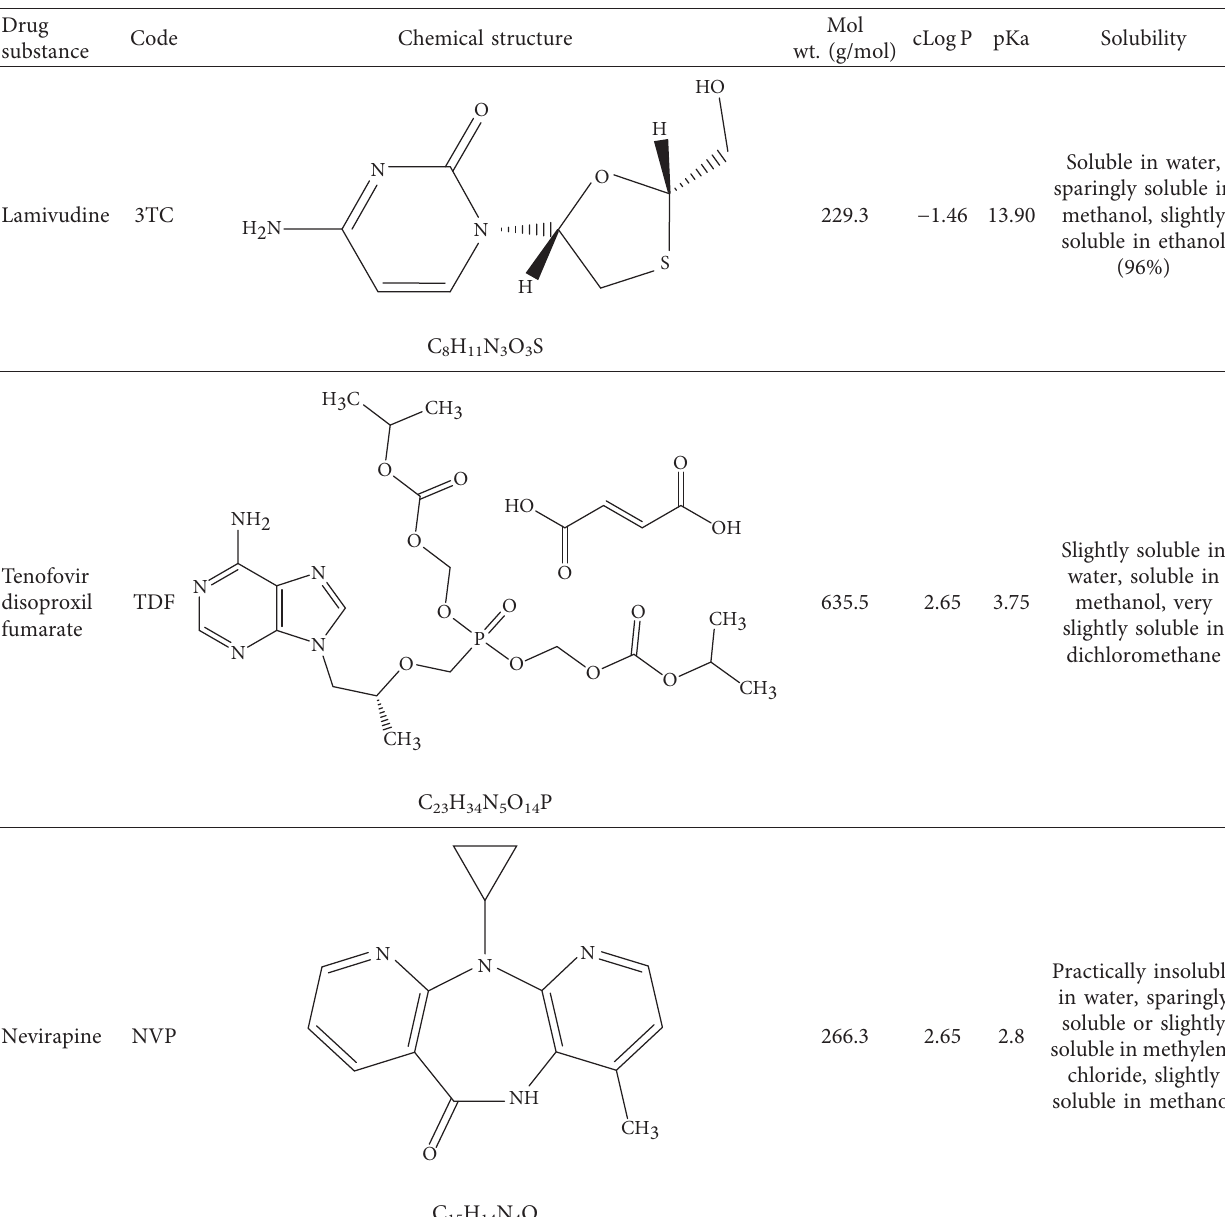
Table 1: Chemical data on drug substances considered in the